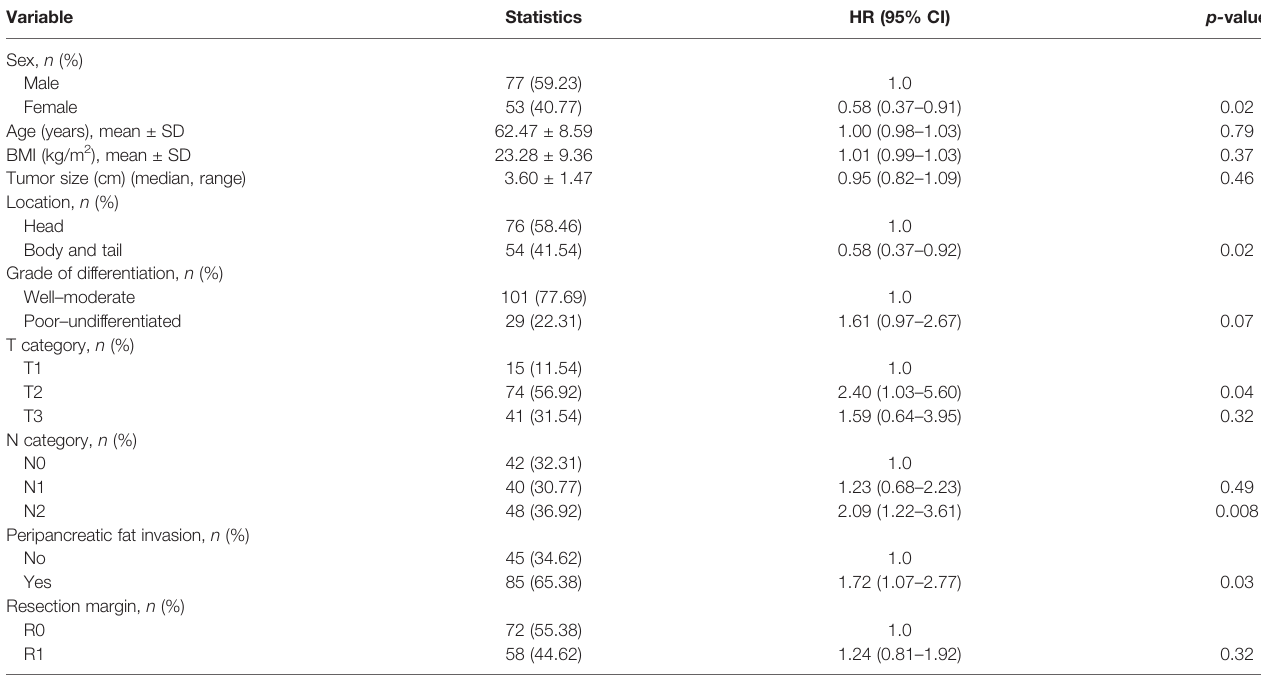
TABLE 1 | Results of the univariate analysis between all variables and overall survival.